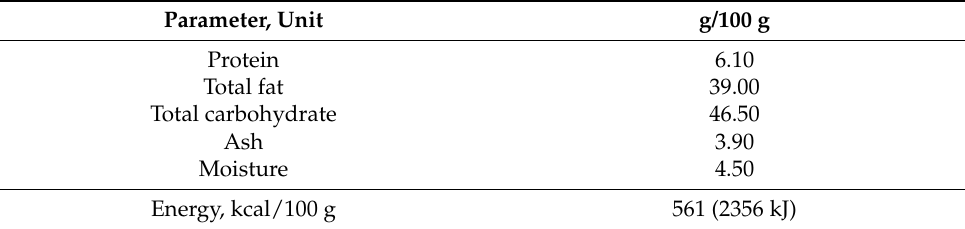
Table 1. Composition of